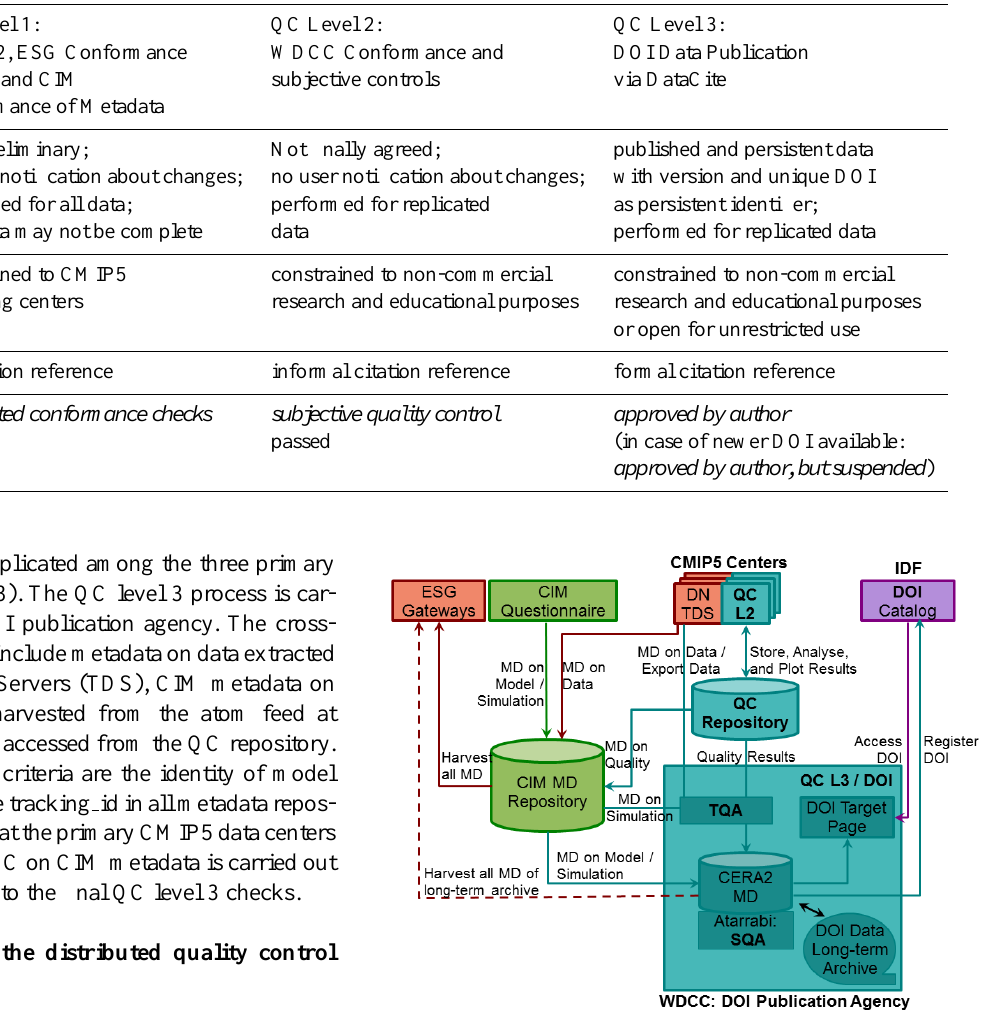
Fig. 4. Implementation of the distributed quality control